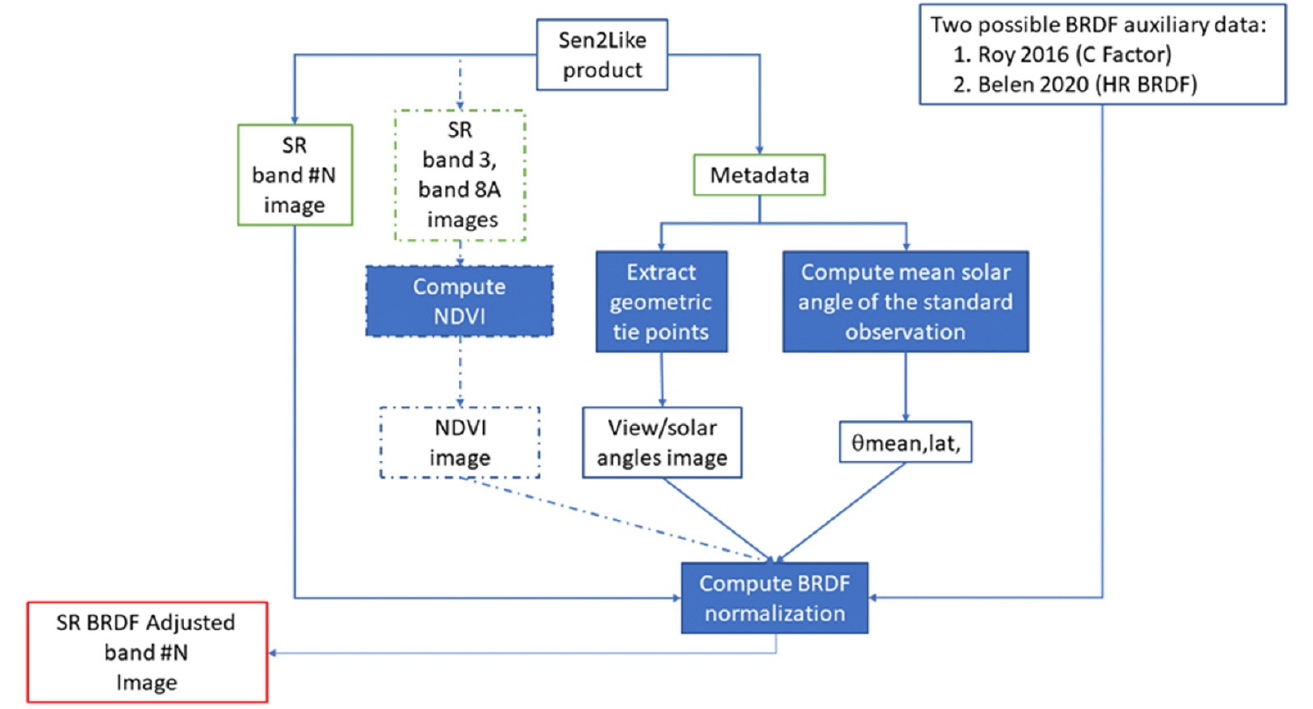
Figure 4. S2L BRDF correction workflow.